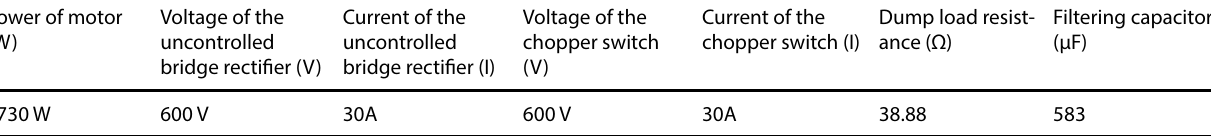
Table 1 Rating of various components Power of motor